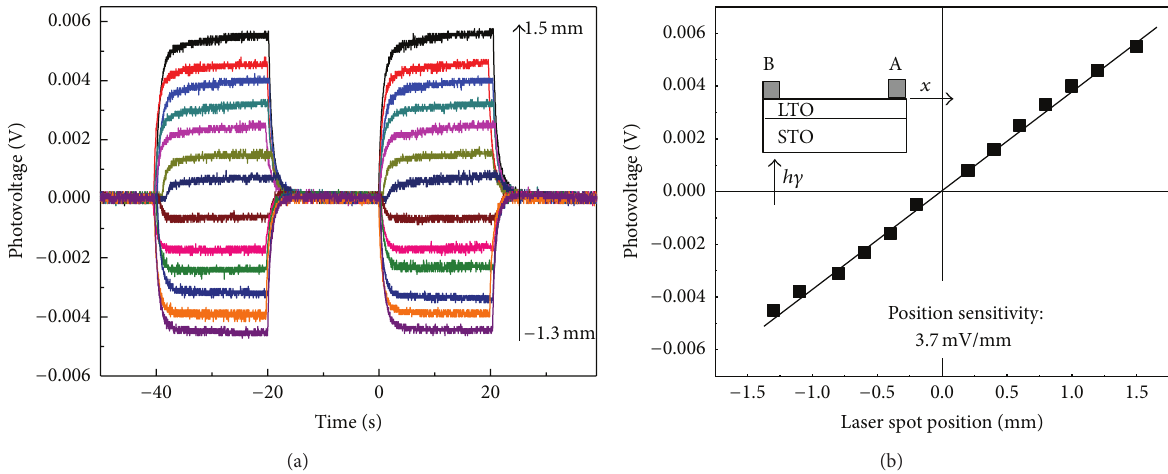
Figure 2: (a) The typical waveforms recorded by oscilloscope with 1M Ω input impedance without any bias when laser spot irradiated region from A to B. (b) The steady waveforms’ peak voltages depended linearly on the spot positions through the zero point.